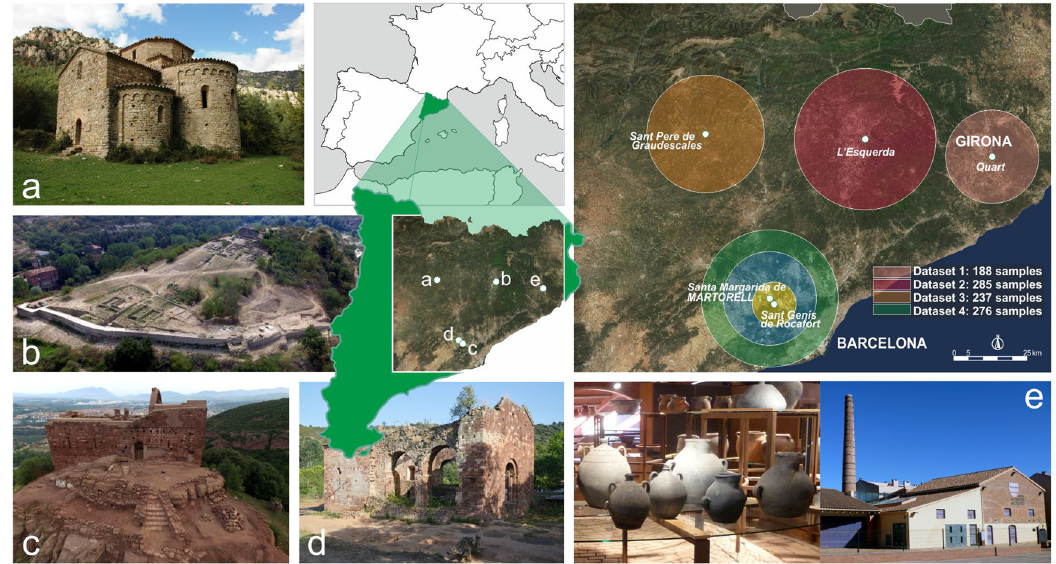
Figure 2: Location of the selected sites and datasets and general overview of the sites: Sant Pere de Graudescales ( a ) [ picture by Josep Renalias ] , L ’ Esquerda ( b ) [ picture by Daniel Robles ] , Sant Genís de Rocafort ( c ) , Santa Margarida ( d ) [ both pictures by Josep Socorregut & Pablo Del Fresno ] , and the reference collection at the former Pottery Museum of Quart ( e ) [ pictures by Joan Vicens ] . Ortophotograph and base mapping provided by the Institut Cartogrà fi c de Catalunya, ICC. Dataset 4 includes samples from two close sites: Santa Margarida ( 188 samples, the proportion of samples is represented in blue on the map ) and Sant Genís de Rocafort ( 88 samples, represented in yellow on the map )